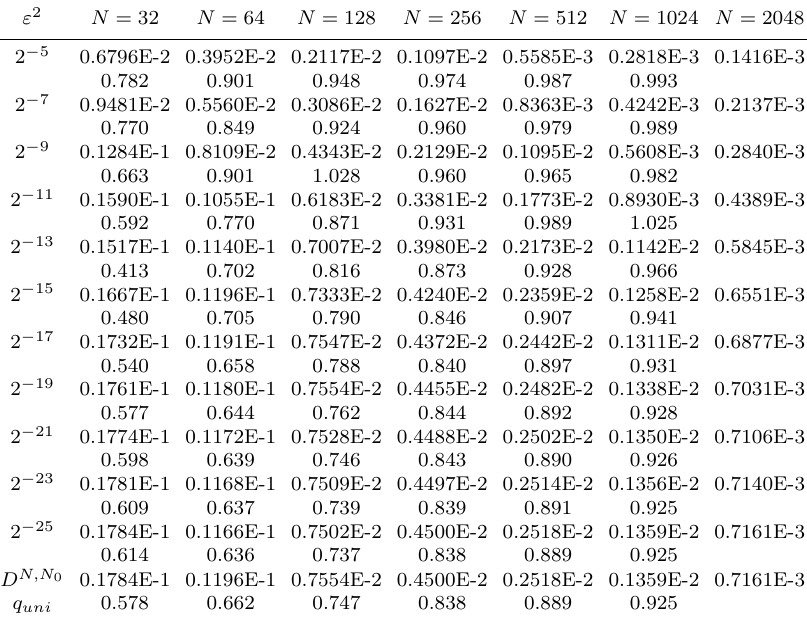
Table 2. Maximum errors and ε -uniform orders of convergence on the Shishkin mesh for problem (4.1), (4.2) with m = 1 / 2 ε 2 N =